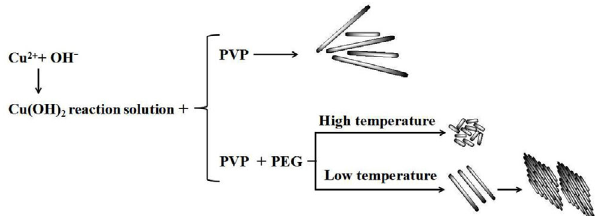
Fig. 4 Schematic diagram of the formation process of CuO nanostructures.